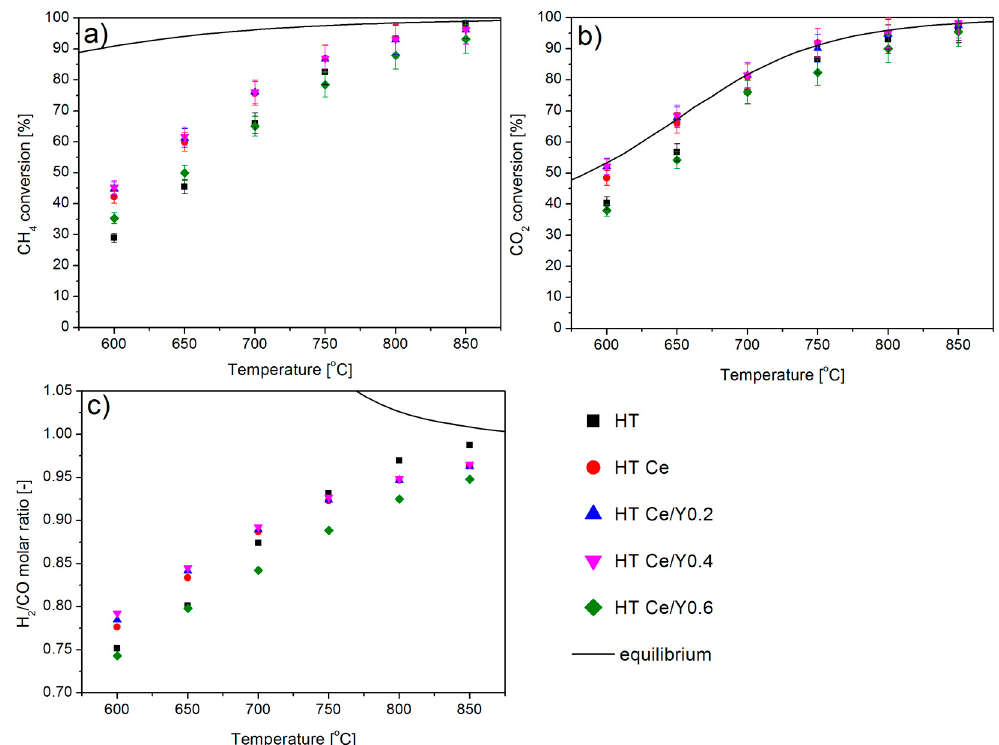
Figure 5. The results of DRM catalytic tests over Ce- and Y-modified catalysts: ( a ) CH 4 conversion, ( b ) CO 2 conversion and ( c ) H 2 /CO molar ratio. Reaction conditions: T = 850–600 ◦ C, 30 min at each temperature, GHSV = 20,000 h − 1 , CH 4 /CO 2 /Ar = 1/1/8, total flow rate 100 cm 3 /min. Table 3. DRM catalytic results over Ce and Ce,Y modified catalysts at different temperatures (from 850 to 600 ◦ C, GHSV = 20,000 h − 1 , CH 4 /CO 2 /Ar = 1/1/8, total flow rate 100 cm 3 /min).